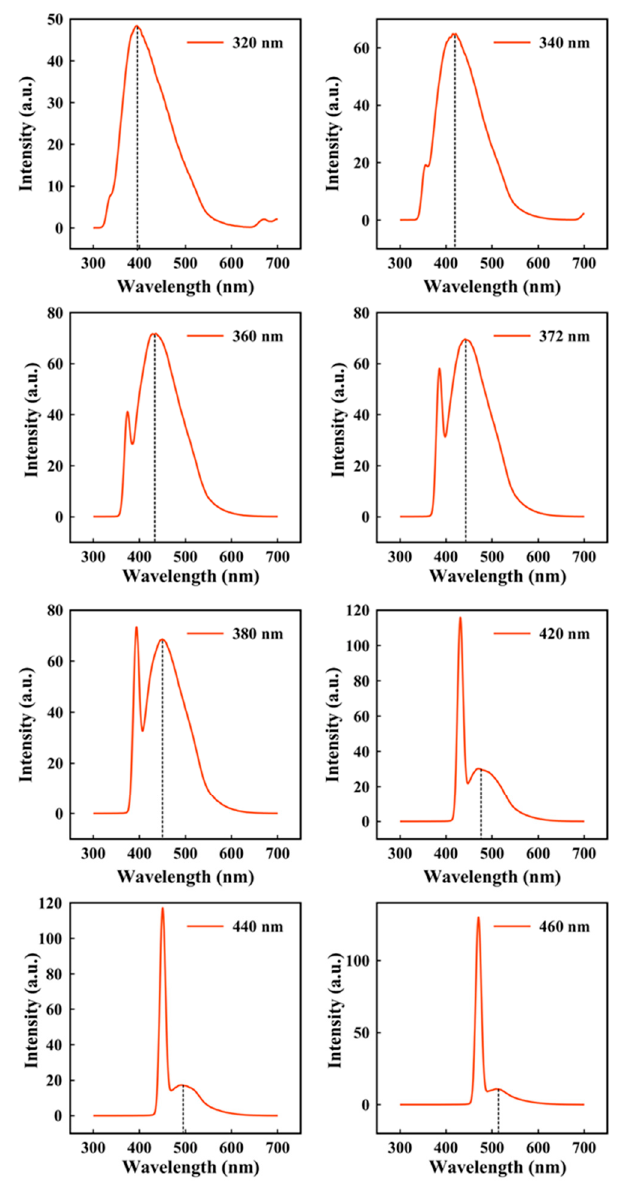
Figure 6. Fluorescence emission spectra of the prepared CNPs at various excitation wavelength. DLS measurements determined the size and size distribution of the fabricated CNPs.